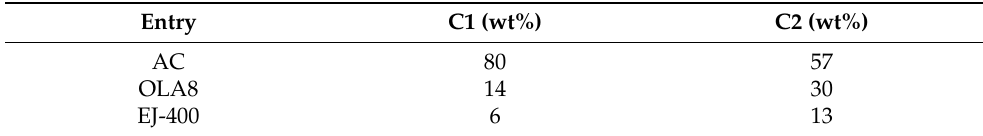
Table 5. Composition of C1 and C2